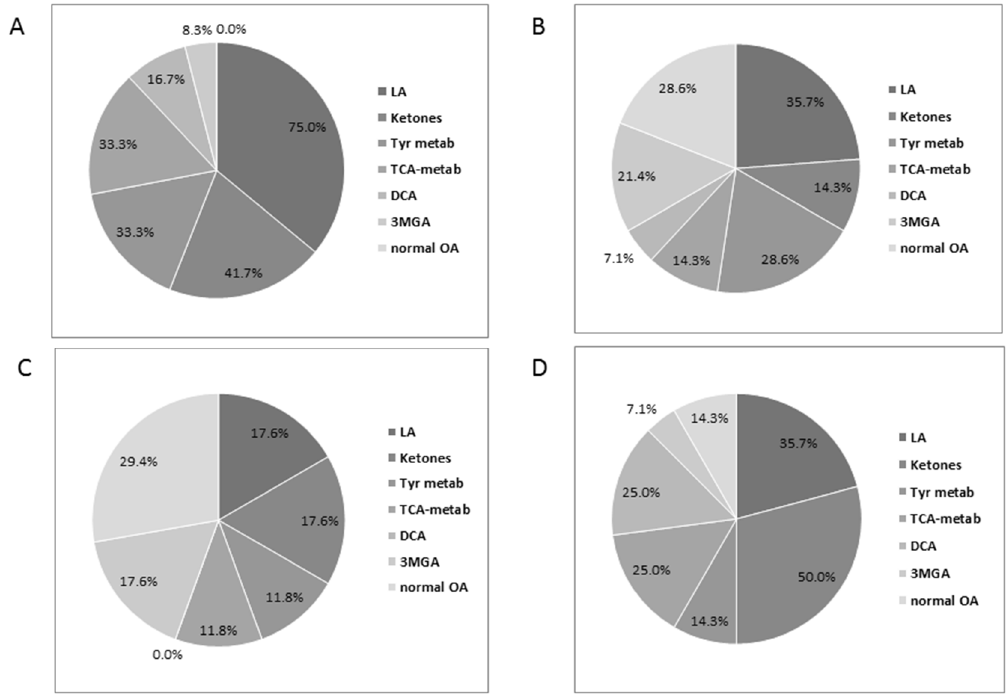
Figure 5. Urinary organic acids in ( A ) CI defects; ( B ) CIV defects; ( C ) CV defects; ( D ) combined defects with normal CII.